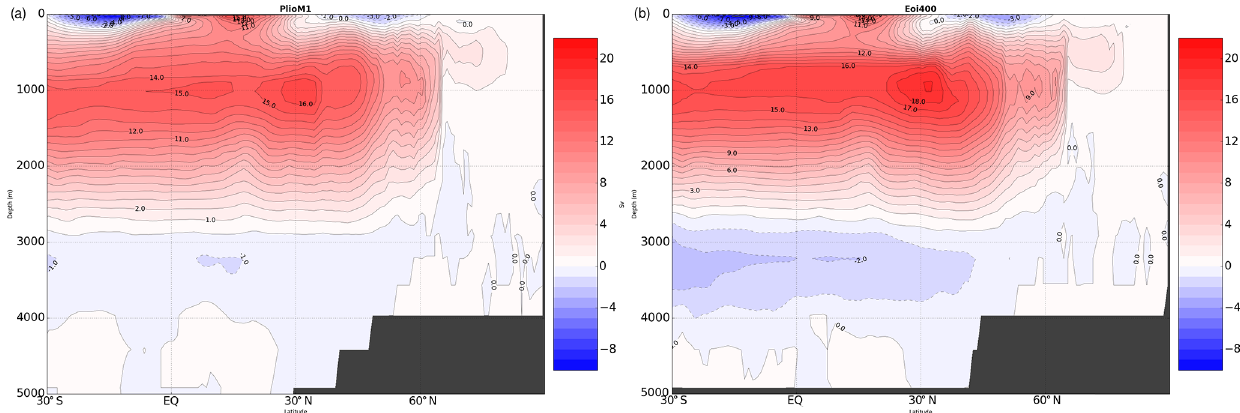
Figure 7. COSMOS-simulated mid-Pliocene annual mean AMOC in Sverdrups for (a) PlioMIP1 (simulation PlioM1) and (b) PlioMIP2 (simulation Eoi400). Overturning rates are time averages that have been calculated from 100-year model outputs. Positive values represent a clockwise